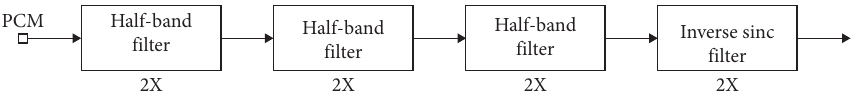
Figure 3: Block diagram of the 16x interpolation